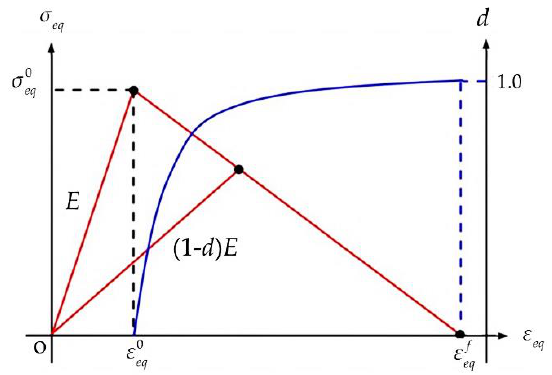
Figure 4. Bilinear constitutive relation. E is the elastic modulus of the undamaged